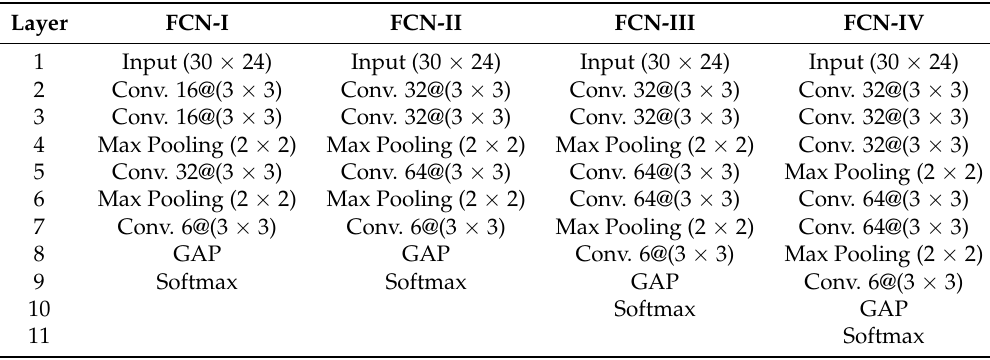
Table 1. Network